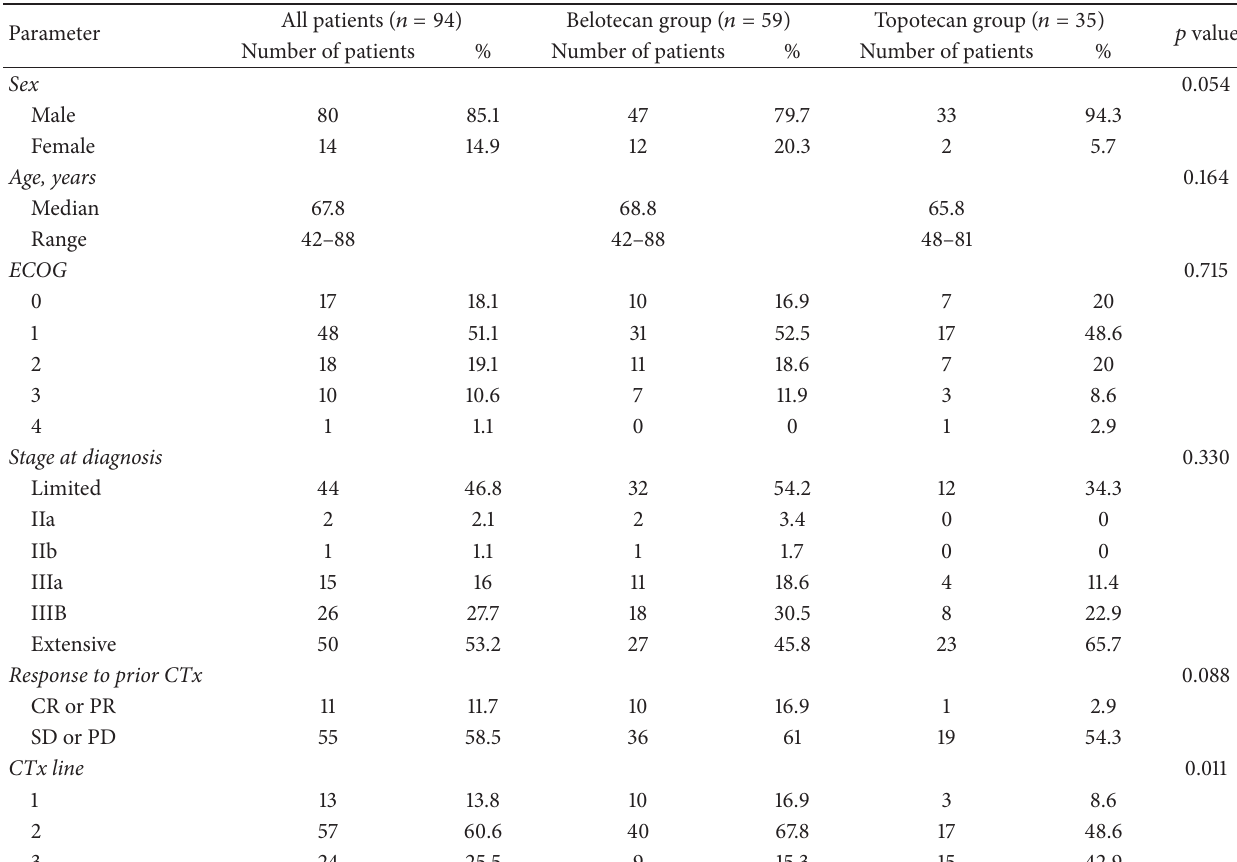
Table 1: Baseline characteristics.